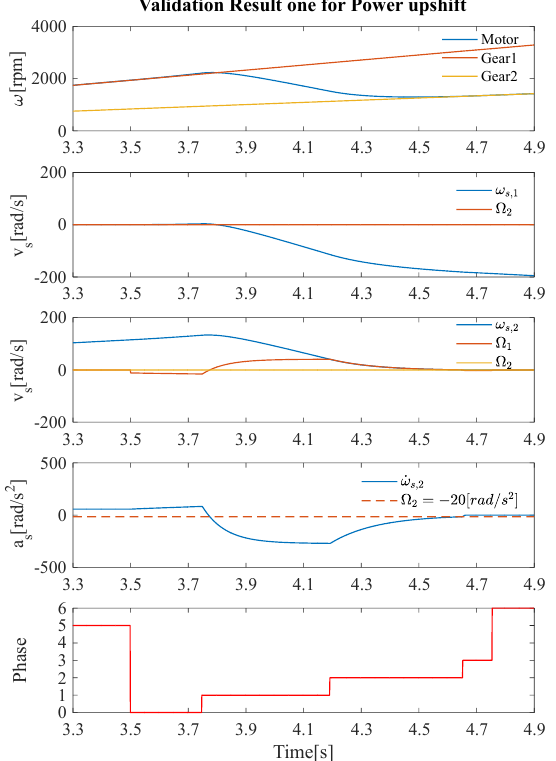
Figure 9. Simulation results illustrating the control strategy and the performance during the upshift- ing process.